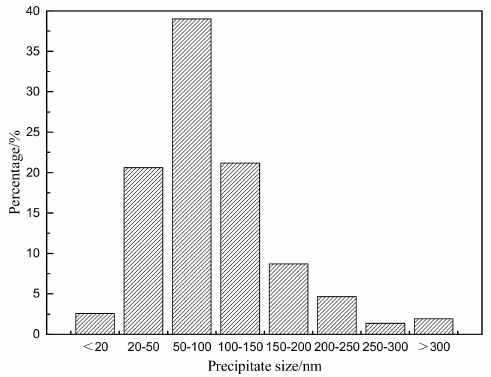
Figure 7. Size distributions of precipitates in a decarburized